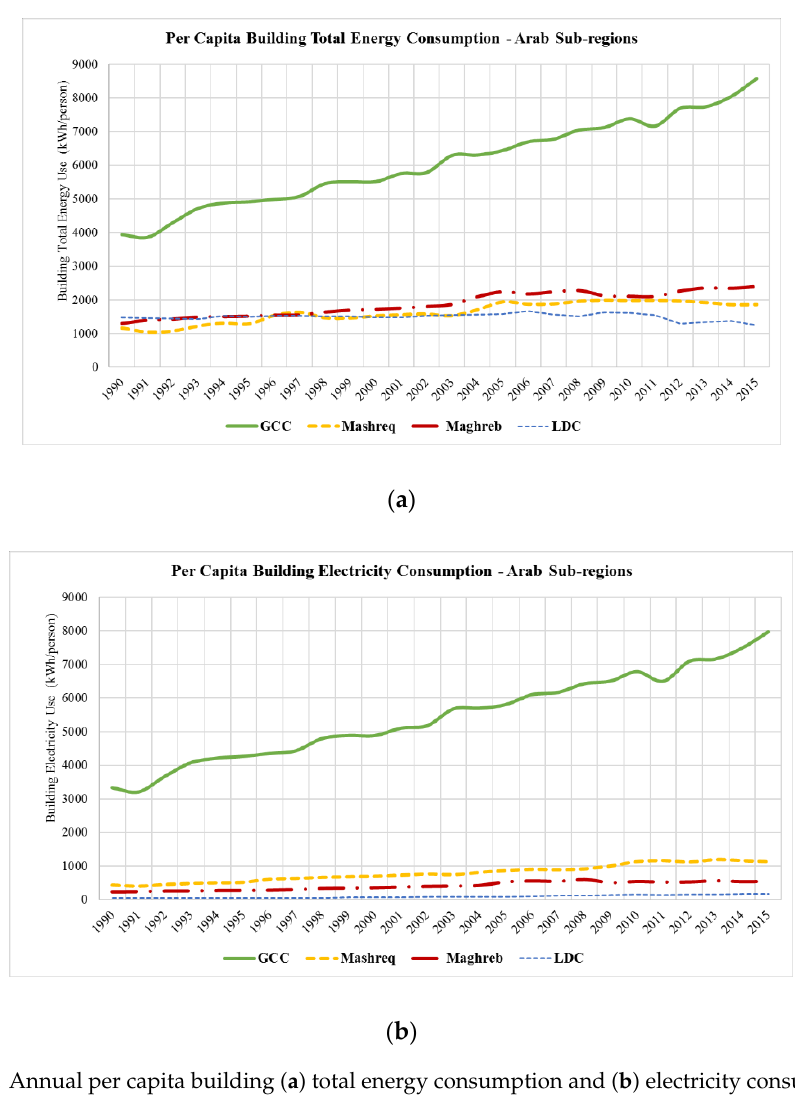
Figure 13. Annual per capita building ( a ) total final energy consumption and ( b ) total electricity consumption of the Arab region compared to those of the US, EU, and World.